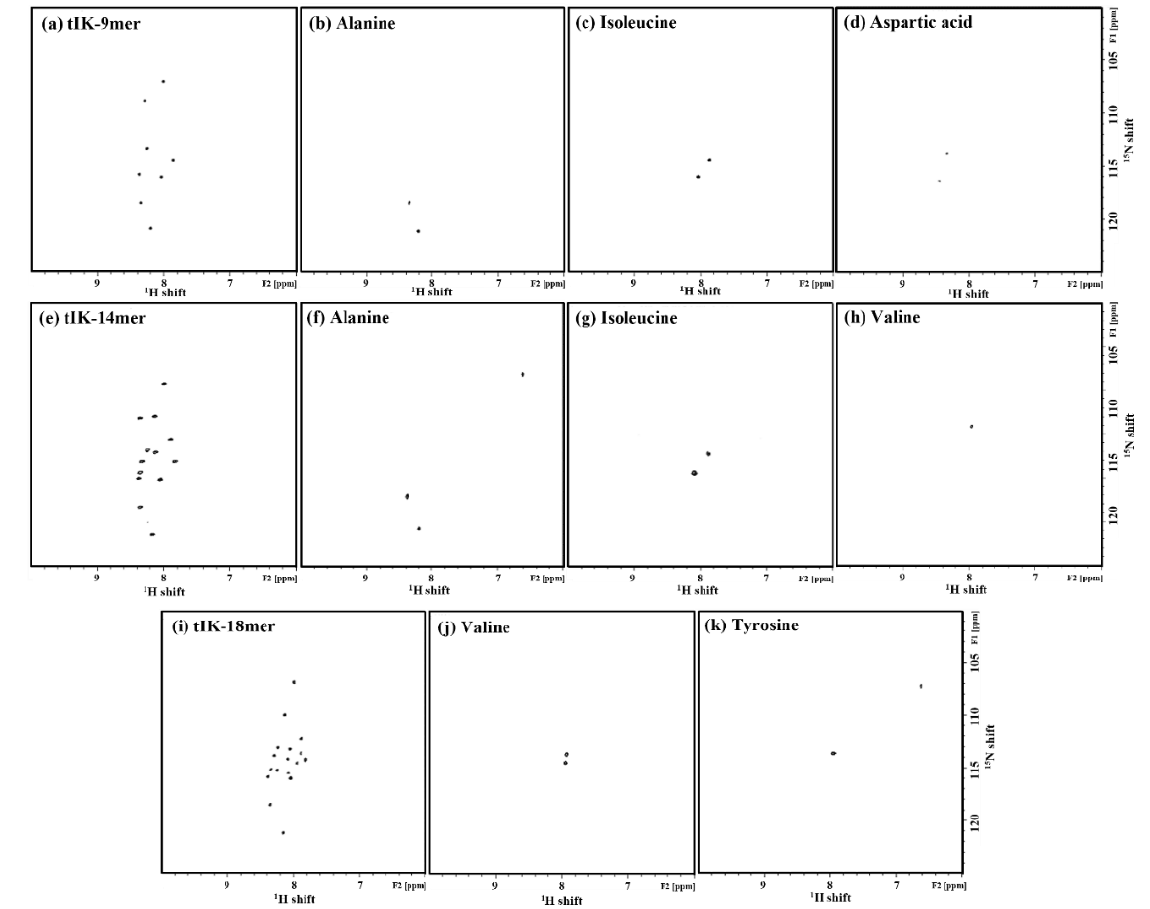
Figure 6. 1 H– 15 N HSQC NMR spectra of uniformly 15 N-labeled ( a ) tIK-9mer, ( e ) tIK-14mer, and ( i ) tIK-18mer. The 9mer was selectively 15 N-labeled with ( b ) Ala, ( c ) Ile, and ( d ) Asp; the 14mer was selectively 15 N-labeled with ( f ) Ala, ( g ) Ile, ( h ) Val; and the 18mer was selectively 15 N-labeled with ( j ) Val and ( k ) Tyr to obtain a peptide. All spectra were recorded with 1 mM tIK series peptides at 298 K and pH 2.0 by using Bruker Avance 400 MHz NMR (Bruker Biospin, Rheinstetten, Germany).